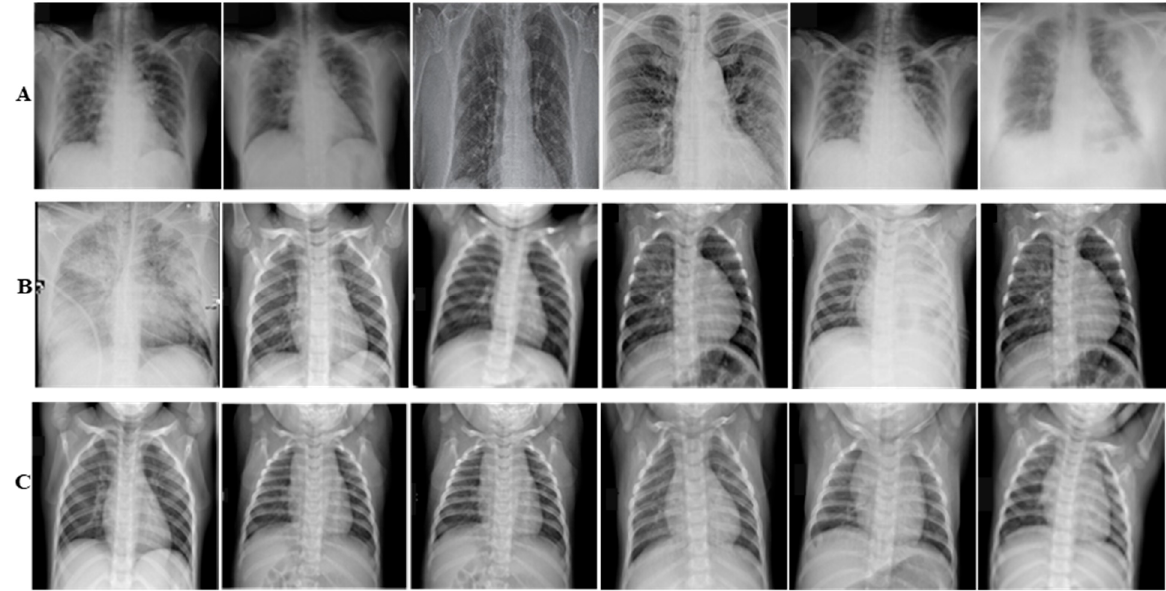
Figure 1. Panel ( A – C ) illustrate COVID-19, Non-COVID-19, and Healthy X-ray images, respec-